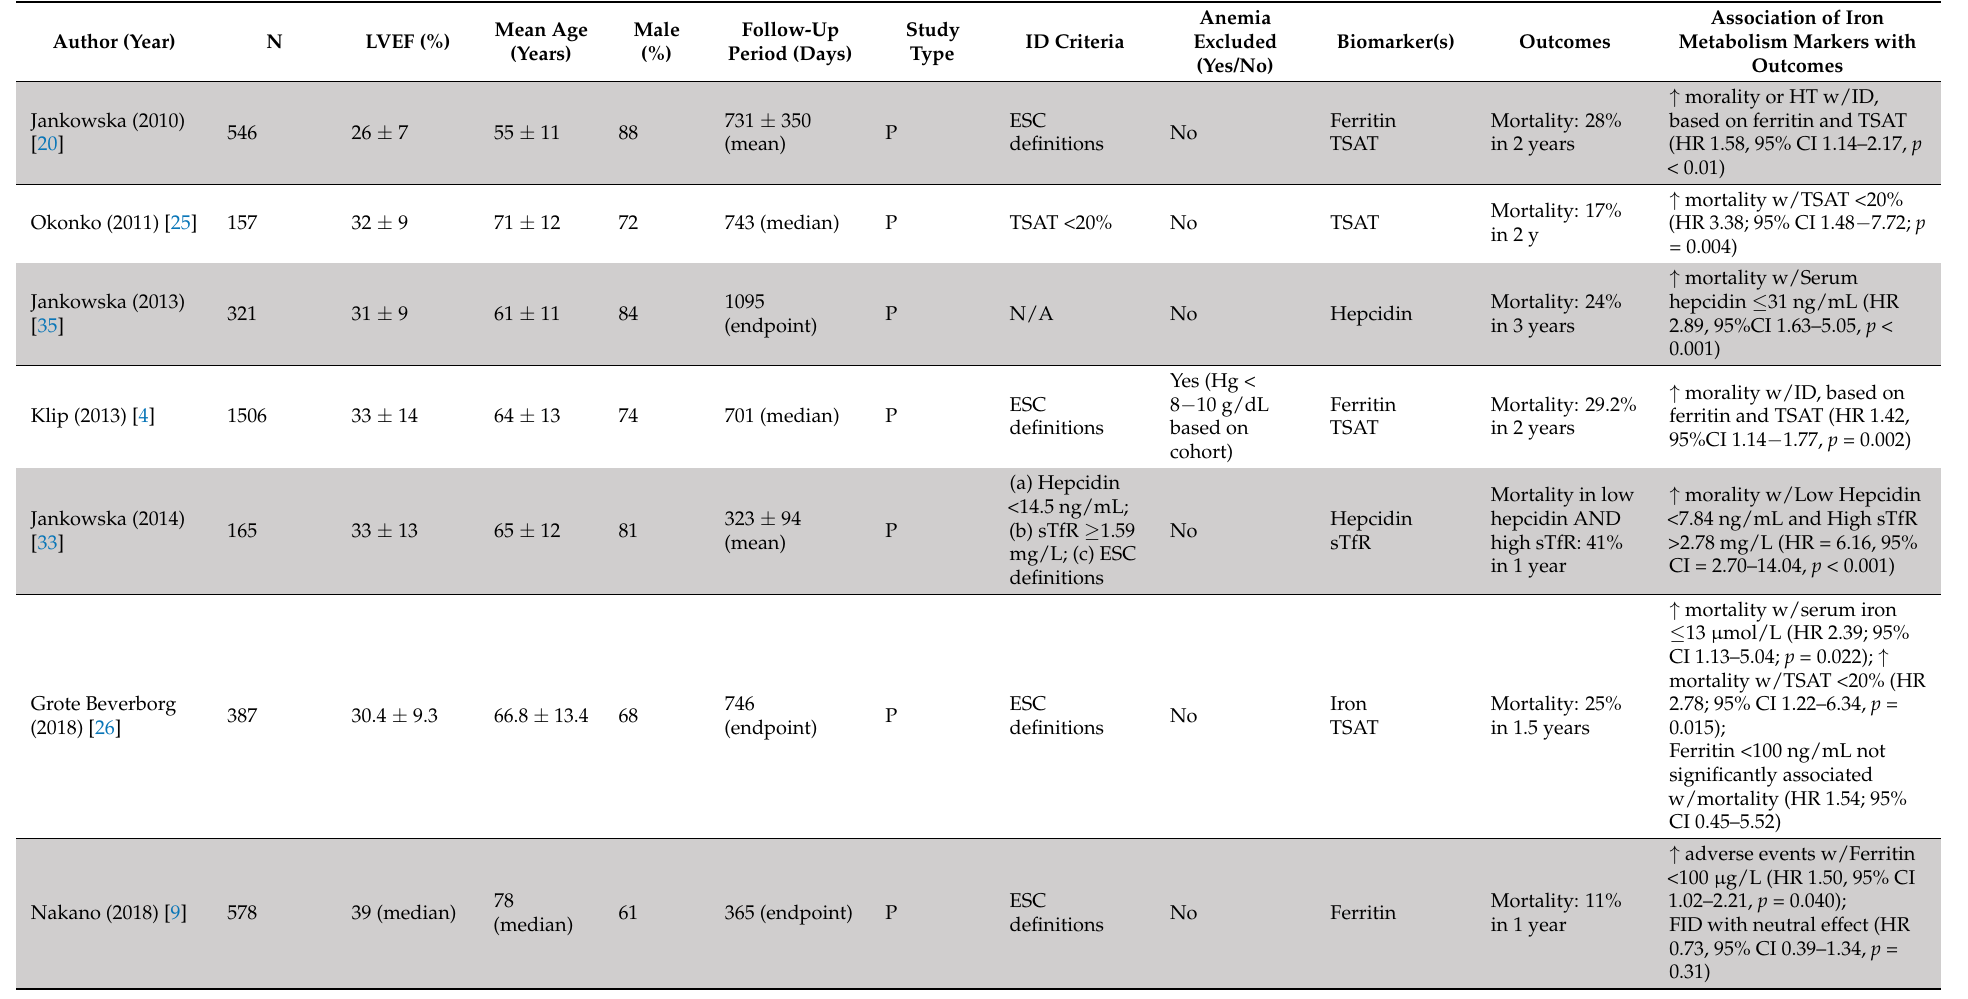
Table 1. Characteristics of Studies Associating Biomarkers of Iron Metabolism with All-Cause